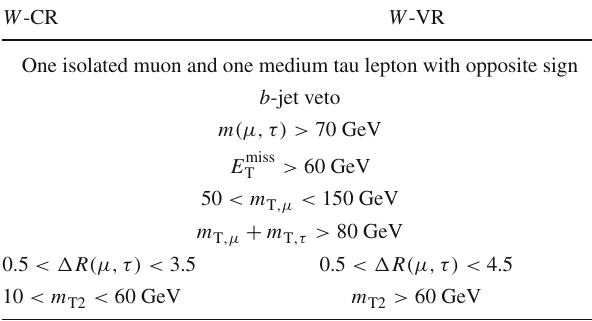
Table 4 The W -CR (left) and W -VR (right) definitions